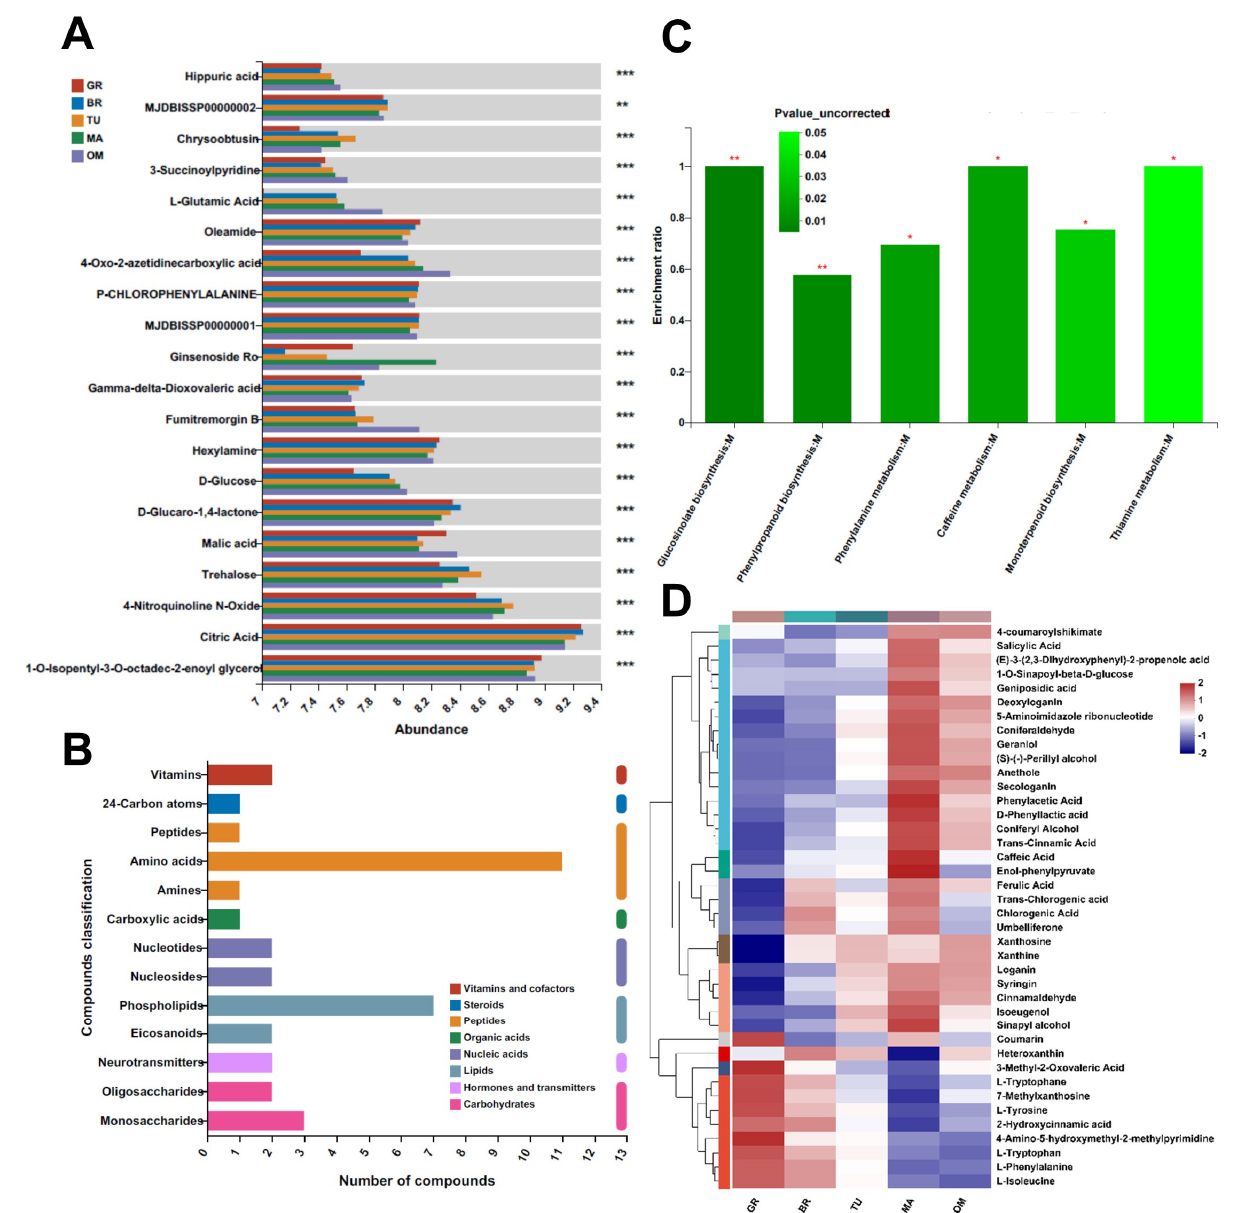
Figure 4. Metabolite changes during fruit ripening. Representative metabolites with significant dif ‐ ferences between different stages ( A ). KEGG compound classification ** p < 0.01 and *** p < 0.001 according to one ‐ way ANOVA; ( B ) and KEGG analysis ( C ) of mature changed metabolites. Heatmap indicates the relative abundance of metabolites within the enriched KEGG pathways of glucosinolate biosynthesis, phenylpropanoid biosynthesis, phenylalanine metabolism, caffeine metabolism, monoterpenoid biosynthesis, and thiamine metabolism, * p < 0.05 and ** p < 0.01 ( D ). GR, Green ripe; BR, Break; TU, Turning; MA, Mature; OM, Over ‐ mature.